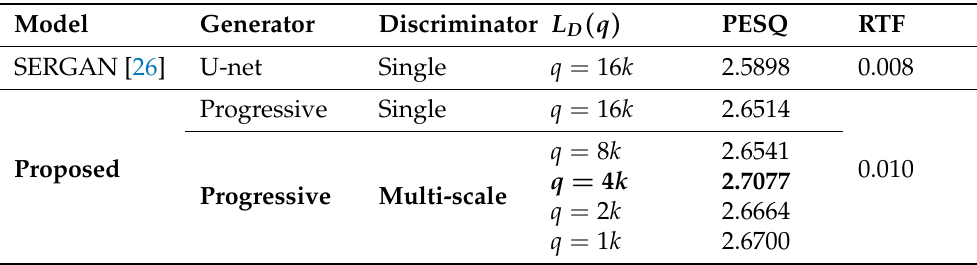
Table 3. Comparison of results between different architectures of the multi-scale discriminator. Except for the SERGAN, the generator of all architectures used the best model in Table 2. The best model is shown in bold